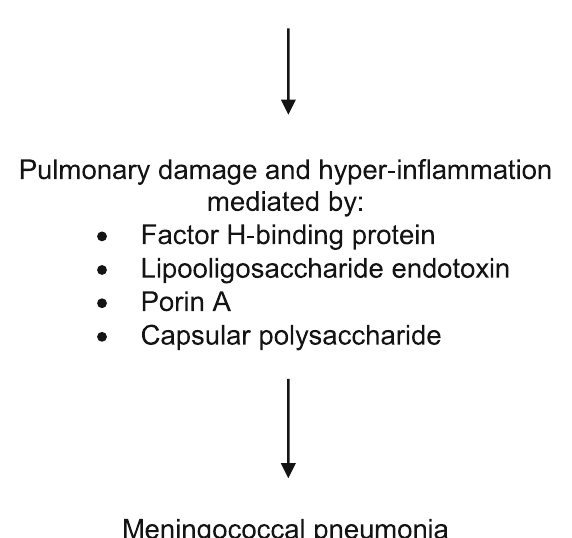
Fig. 1 Possible stages in the pathogenesis of meningococcal